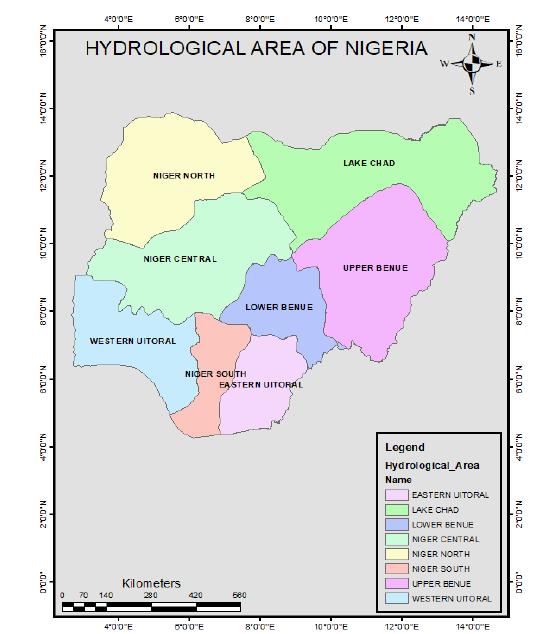
Figure 1. Hydrological Divisions of Nigeria (modified after Iguniwari and George, 2018)